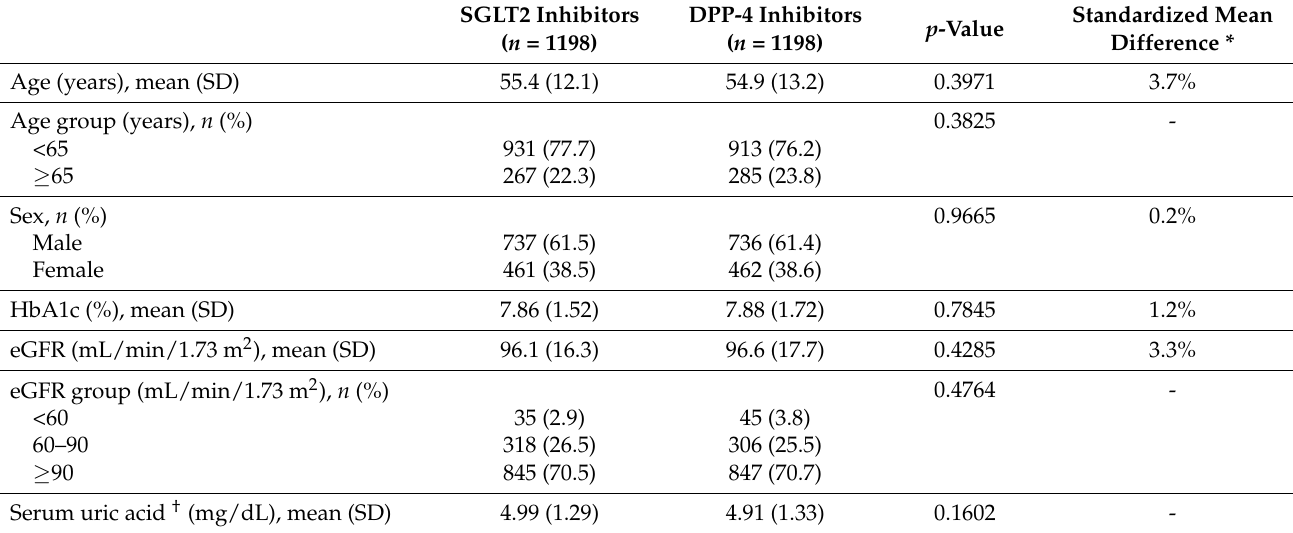
Table 1. Baseline characteristics of propensity-score-matched pairs of the SGLT2 inhibitors group and DPP-4 inhibitors